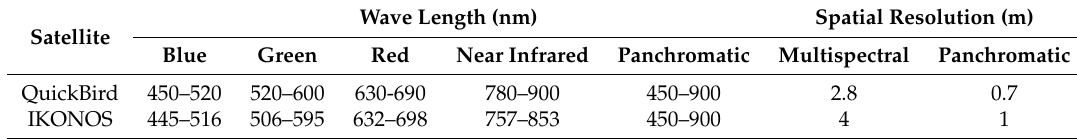
Table 3. Spectral and spatial resolution of QuickBird and